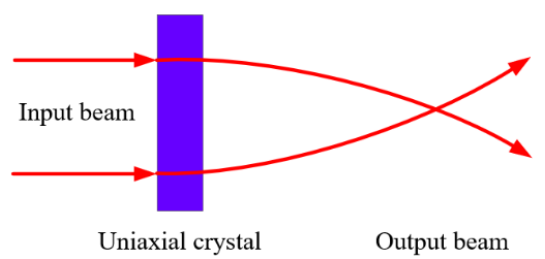
Figure 1. The schematic diagram of controlling the abrupt autofocusing of CAVB via uniaxial crystal when the focal point is outside the uniaxial crystal.